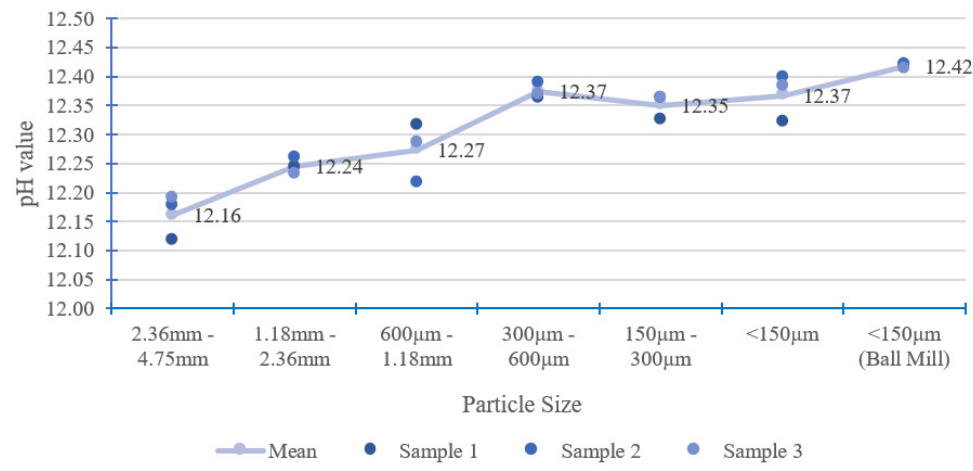
Figure 5. Effect of particle size. Table 3. Comparison for pH among mortar, paste and concrete samples with similar particle sizes.